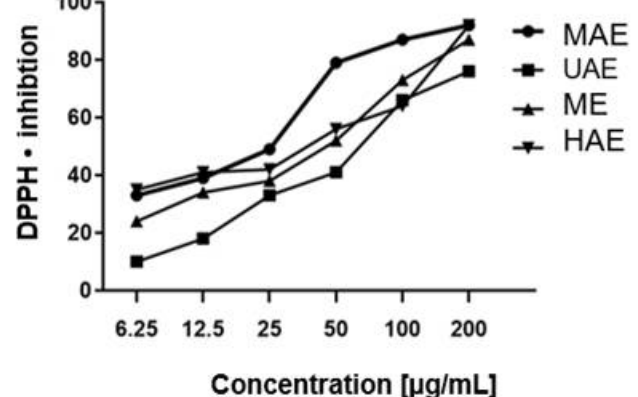
Figure 2. Antioxidant properties of Schisandra chinensis aqueous extract against DPPH free radical solutions. MAE–microwave-assisted extraction; UAE-ultrasound-assisted extraction; ME–